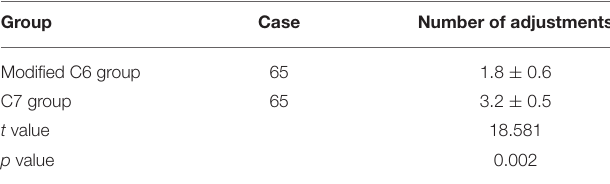
TABLE 3 | Comparison of the number of adjustments in the two groups of patients ( x ± s,times).